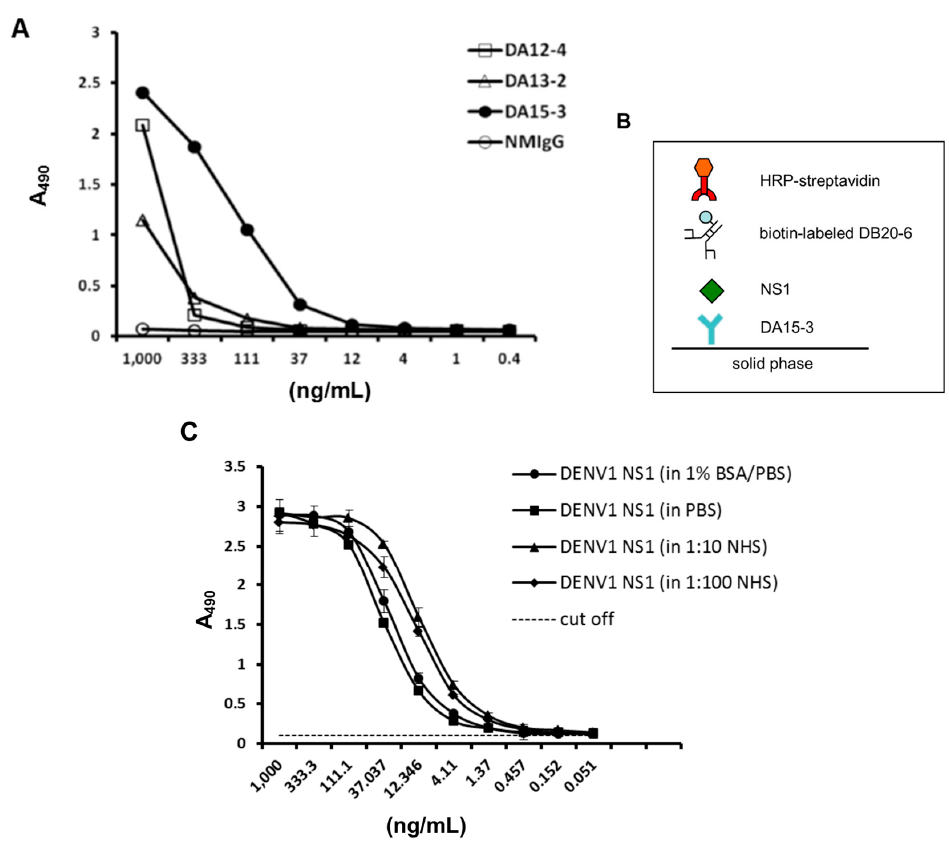
Figure 2. Development of an ELISA-based diagnostic platform for DENV1. ( A ) Direct ELISA was used to compare a panel of mAbs against serial dilutions of immunoaffinity-purified DENV1 NS1 protein. The ELISA plate was coated with a three-fold dilution of purified DENV1 NS1 protein. After washing, the coated NS1 protein was detected with the indicated mAb at a concentration of 1 μ g/mL. Normal mouse IgG (NM-IgG) was used as the negative control; ( B ) Schematic describing the diagnostic platform; ( C ) Standard curve of DENV1 NS1 in different buffer systems. DENV1 NS1-specific mAb, DA15-3, was used to coat an ELISA plate at a concentration of 50 μ g/mL. Immunoaffinity-purified DENV1 NS1 protein was diluted three-fold in different buffers and incubated with the capture mAb. NS1 protein was detected through the scheme shown in panel ( B ). Data points represent the mean ± standard deviation for three replicates. The dashed line represents the cut off value. NHS: normal human serum.